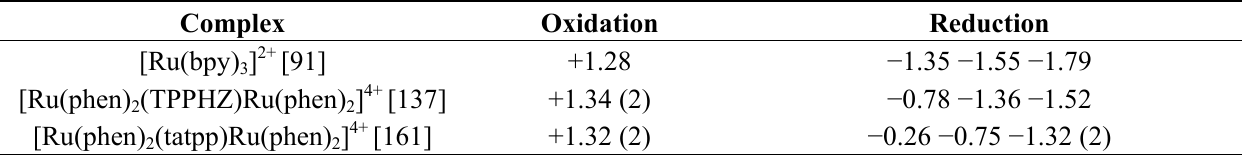
Table 9. Redox potentials V vs. SCE measured in acetonitrile for three Ru II complexes with an increasing π -extended